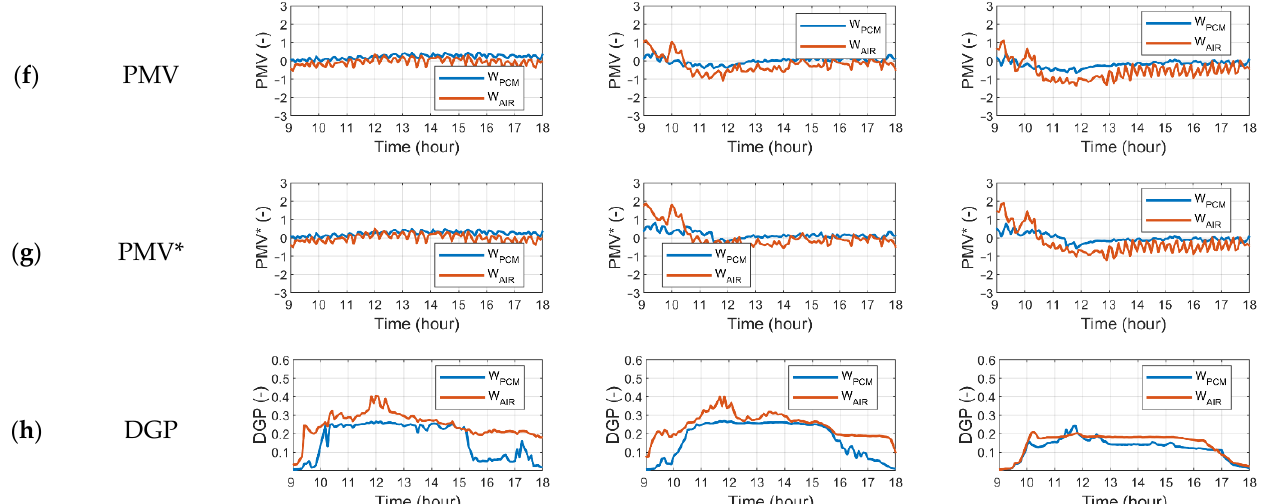
Figure 11. Results for representative days of mid-season cold. ( a ) Outdoor temperature and global horizontal radiation (GHI); ( b ) global vertical radiation; ( c ) HVAC power and energy consumption; ( d ) indoor air temperature & mean radiant temperature (MRT); ( e ) heat flux; ( f ) PMV; ( g ) PMV*; ( h ) DGP. Cloudy Partly cloudy Sunny